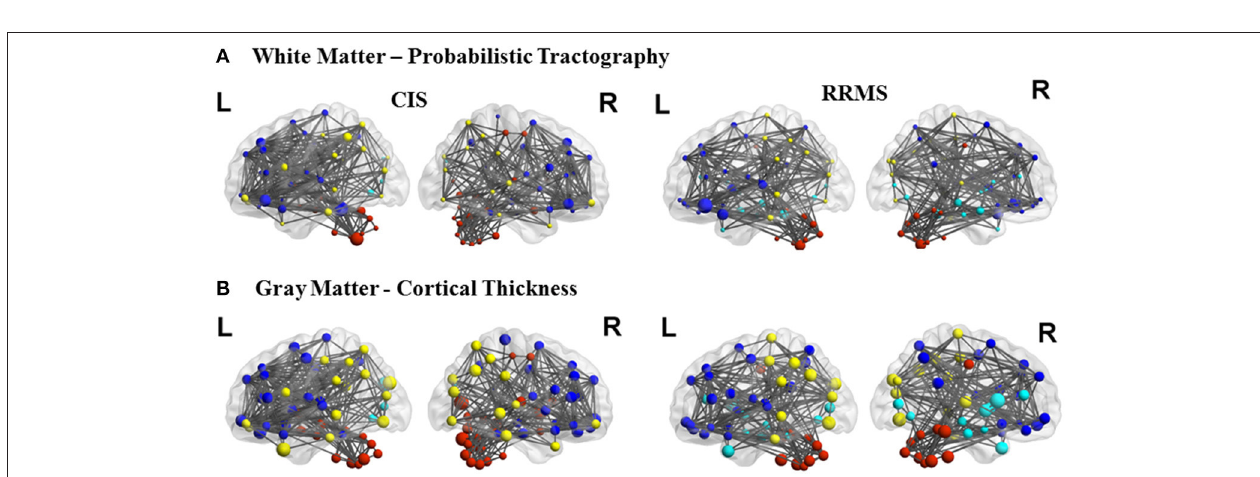
FIGURE 2 | The plots show the estimated values for the parameters modularity, clustering coefficient, and global efficiency for white matter (A) and cortical thickness (B) analyses. The red asterisks indicate the RRMS patients and the blue asterisks represent the CIS patients. The black asterisks in each plot show the density intervals in which there was significant difference ( p < 0.05 ) between the two groups.